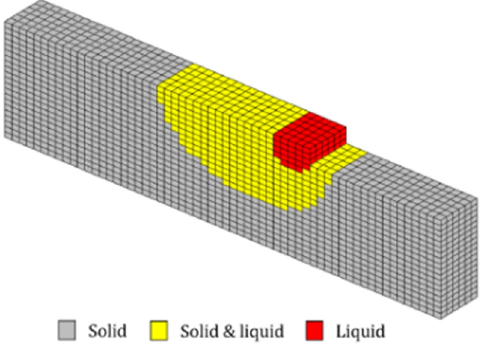
Fig. 4. Melt pool volume (yellow and red) =elements whose temperature exceeds the